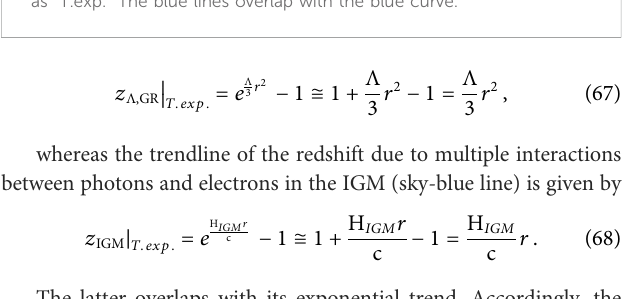
FIGURE 6 Comparison between independent extragalactic redshifts (black dots) and its linear trend (violet line) with nominal redshifts determined by pure formulations (fuchsia, sky-blue, and blue exponential curves) and by Taylor expansion (fuchsia, sky-blue, and blue lines) reported as “ T.exp. ” The blue lines overlap with the blue curve.